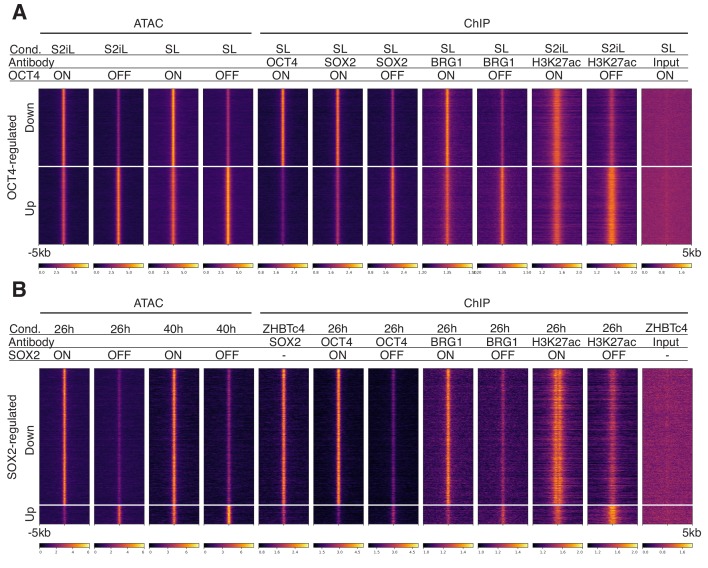
Heatmaps of ATAC-seq and ChIP-seq profiles in OCT4 OFF and SOX2 OFF cell lines at affected loci.Heatmaps of RPKM-normalized ATAC-seq and ChIP-seq binding profiles upon OCT4 (A) and SOX2 (B) depletion 5 kb around OCT4-regulated (A) and SOX2-regulated (B) loci. Each row represents one individual locus and each column represents one experimental condition.